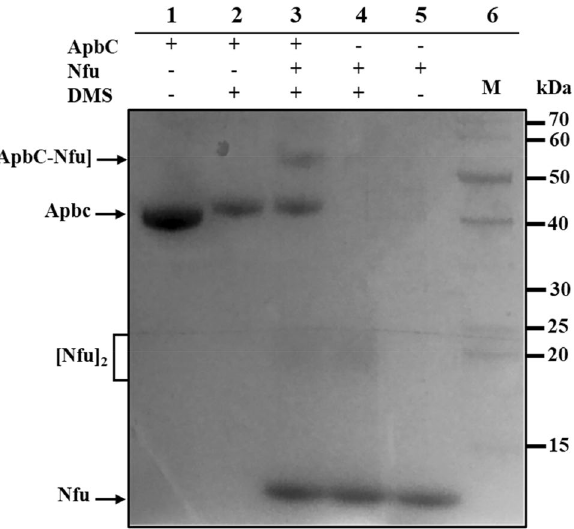
Figure 3. Picture of a gel showing interactions between recombinant ApbC and Nfu proteins. Purified recombinant hexahistidine tagged-ApbC WT (theoretical mass: 41.1 kDa) and recombinant Nfu (10. 1 kDa) were incubated alone or together for 1 h at 25 °C, in absence or presence of the cross linker DMS. Complexes were separated on SDS 4–20% gradient PAGE and stained with Coomassie blue. Conditions are indicated above each lane. Monomeric and dimeric protein complexes are indicated by arrows on the left. A molecular weight ladder was loaded in lane 6, with corresponding molecular masses shown on the